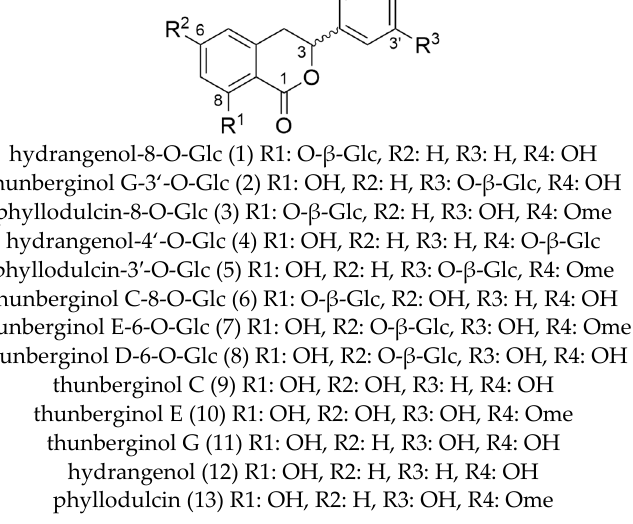
Figure 4. Molecular structures of dihydro-isocoumarins isolated from Hydrangea macrophylla ssp. serrata.